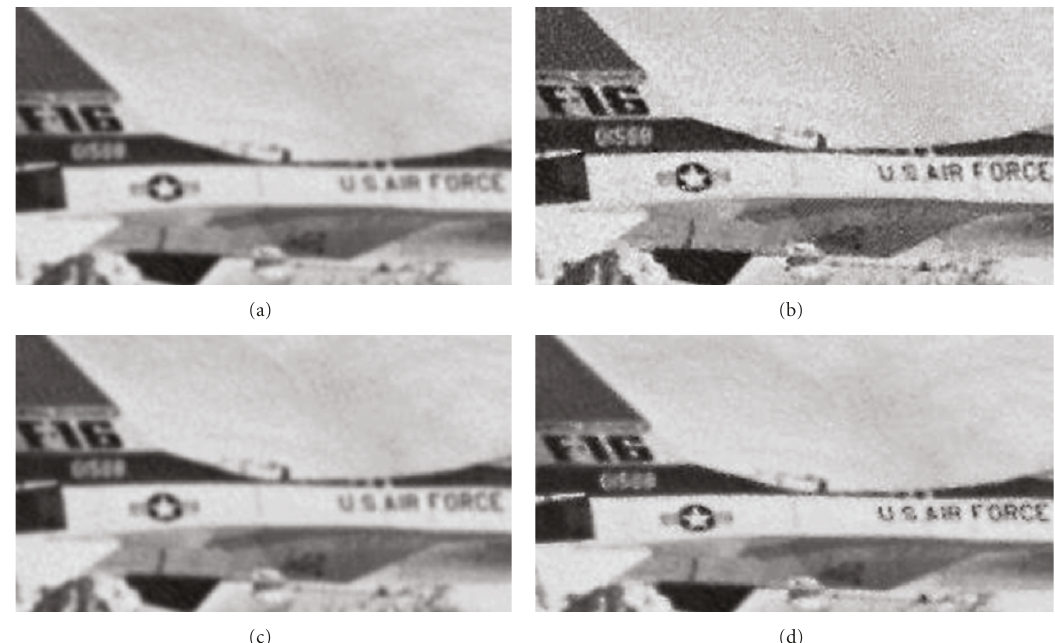
Figure 18: The inverse halftoning result of Airplane using di ff erent methods: (a) the reconstructed image using Gaussian filtering; (b) the reconstructed image using LUT method; (c) the reconstructed image using ELUT method; (d) the reconstructed image using the proposed method.